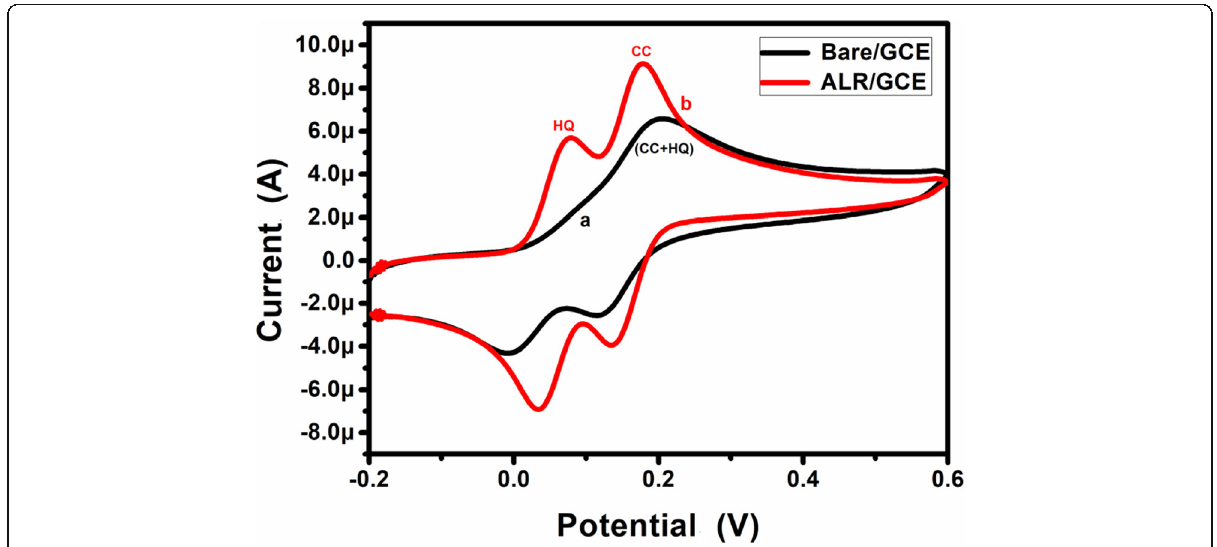
Fig. 3 CVs recorded for the simultaneous determination of equimolar (40.0 μ M) binary mixture of CC and HQ at bare GCE (curve a) and ALR/GCE (curve b) with 0.2 M buffer of pH 7.4 with 0.05 Vs − 1 scan